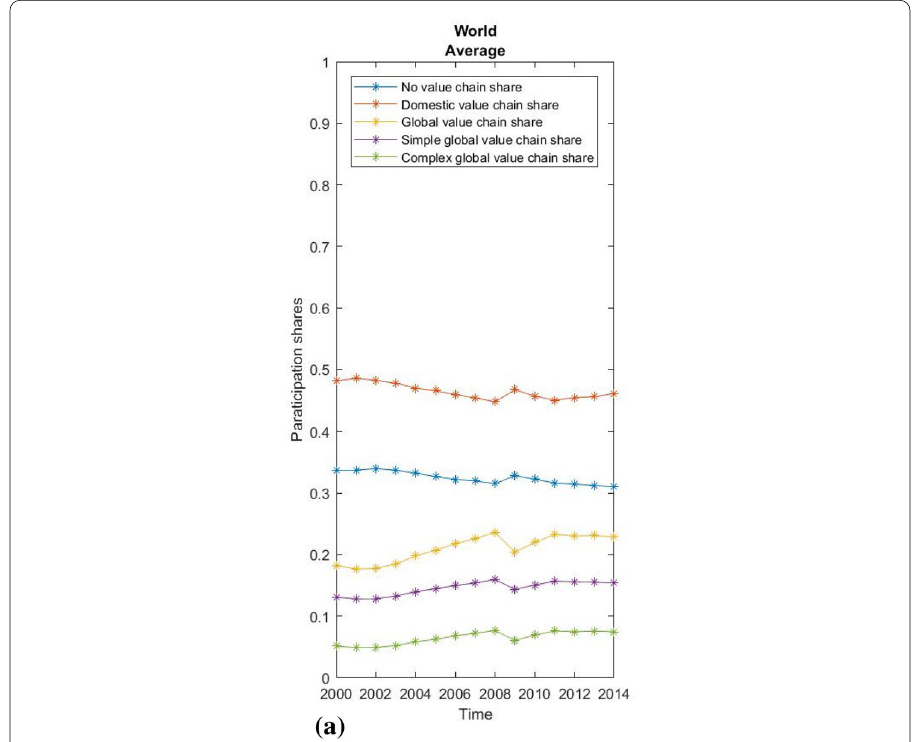
Fig. 2 World average participation rates Source: WIOD, 2016; own